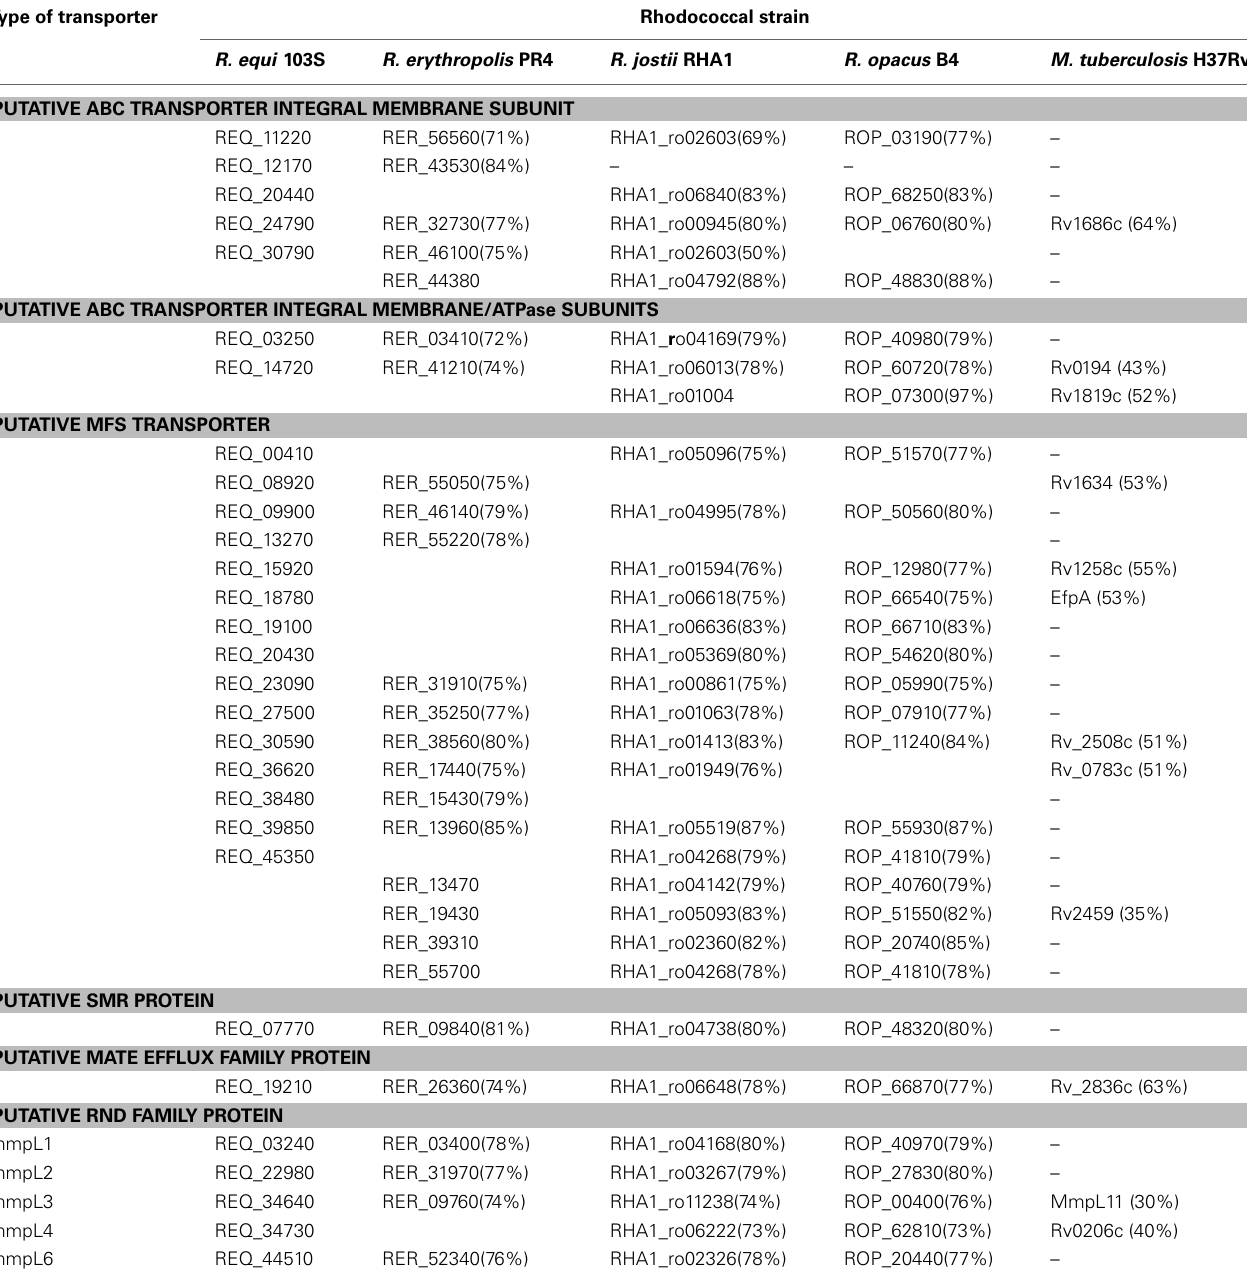
Table 2 | In silico prediction of chromosomal MDR transporter systems involved in resistance to antimicrobial agents in representative rhodococcal species (sharing > 75% identity) and their relation to Mycobacterium tuberculosis H37Rv